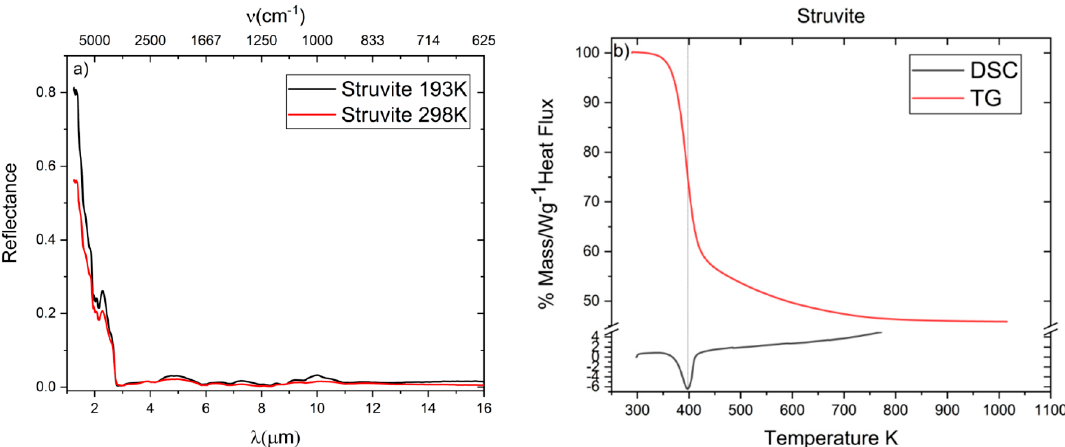
Figure 4. Reflectance spectra at room temperature and 193 K ( a ) and TG / DSC ( b ) analysis from room temperature to 773 and 1023 K of struvite.